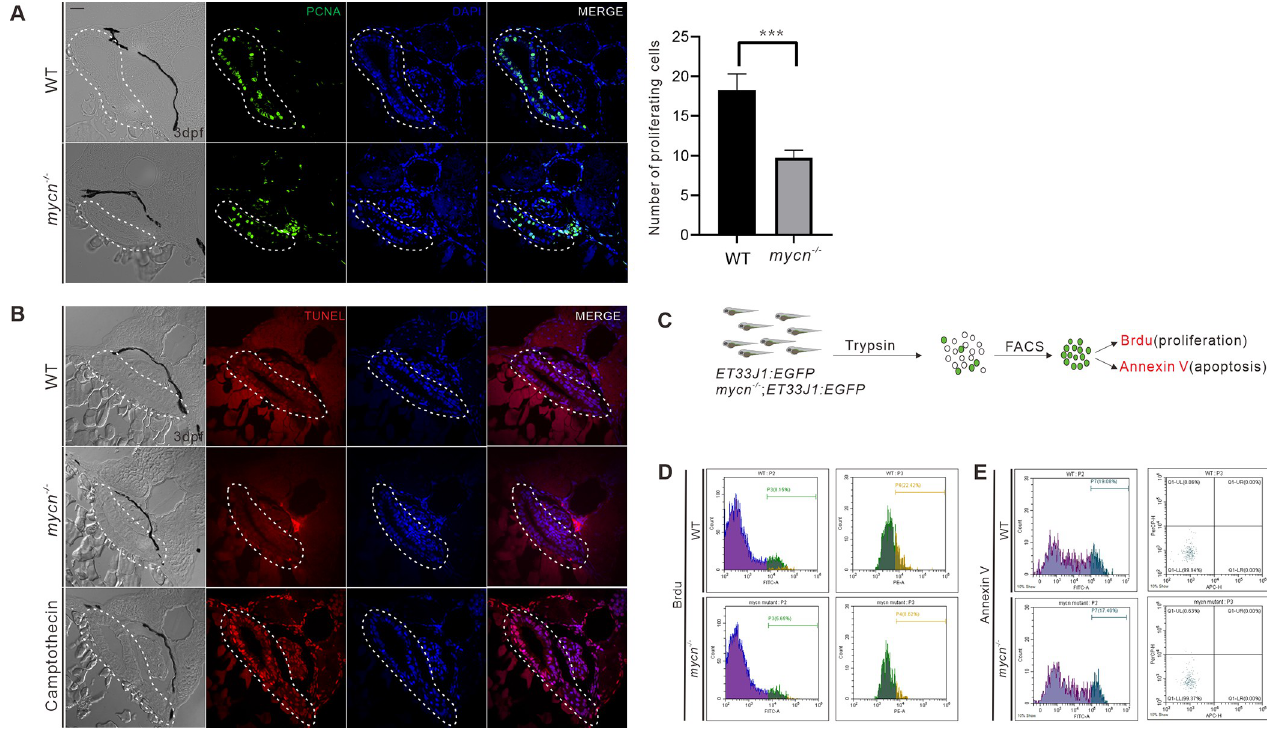
Fig 4. Detection of cell proliferation and apoptosis in intestines of WT and mycn mutant. (A) Cell proliferation in the intestines was detected by PCNA immunofluorescence staining (green signal) of the tissue sections from the WT and mycn mutant embryos. The statistical analysis of the proliferating cells of the sections of intestine in the right. (B) Apoptosis in the intestines was detected via TUNEL assay (red signal) for the tissue sections from the WT, mycn mutant, and camptothecin-treated (as positive control) embryos. Sections were cut along the transverse plane. Dotted lines indicate the intestine positions. (C) Schematic representation of the experimental workflow of the flow cytometry analysis. (D) Cell proliferation in the intestines was detected by BrdU incorporation assay. (E) Apoptosis in the intestines was detected by APC-Annexin V staining. Embryos used in the flow cytometry analysis were descendants of ET33J1 : EGFP reporter line crossed with WT or mycn mutants ( D and E ). Scale bar: 50 μ m. PCNA, proliferating cell nuclear antigen; WT,